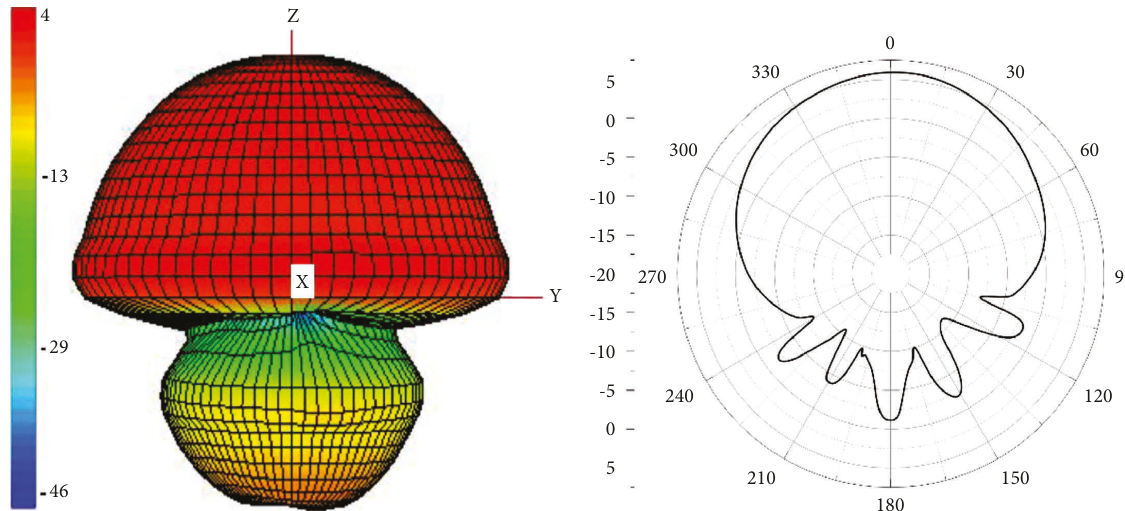
Figure 8: The pattern when the choke is not used (simulated and measured results).